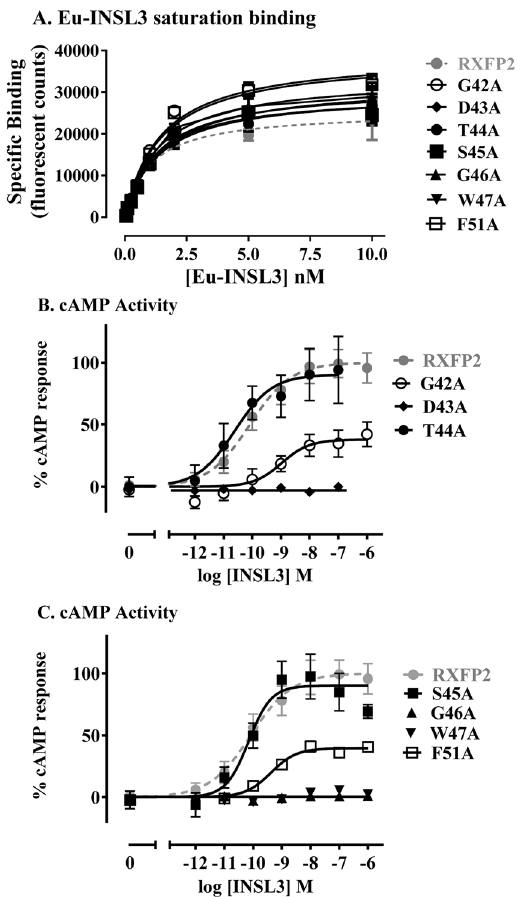
Figure 2. ( A ) Eu-INSL3 saturation binding of RXFP2 mutant receptors compared to wild-type RXFP2. ( B , C ) INSL3-induced cAMP response of RXFP2 mutant receptors compared to wild-type RXFP2. Data is presented as mean ± SEM of triplicate determinations from at least three independent